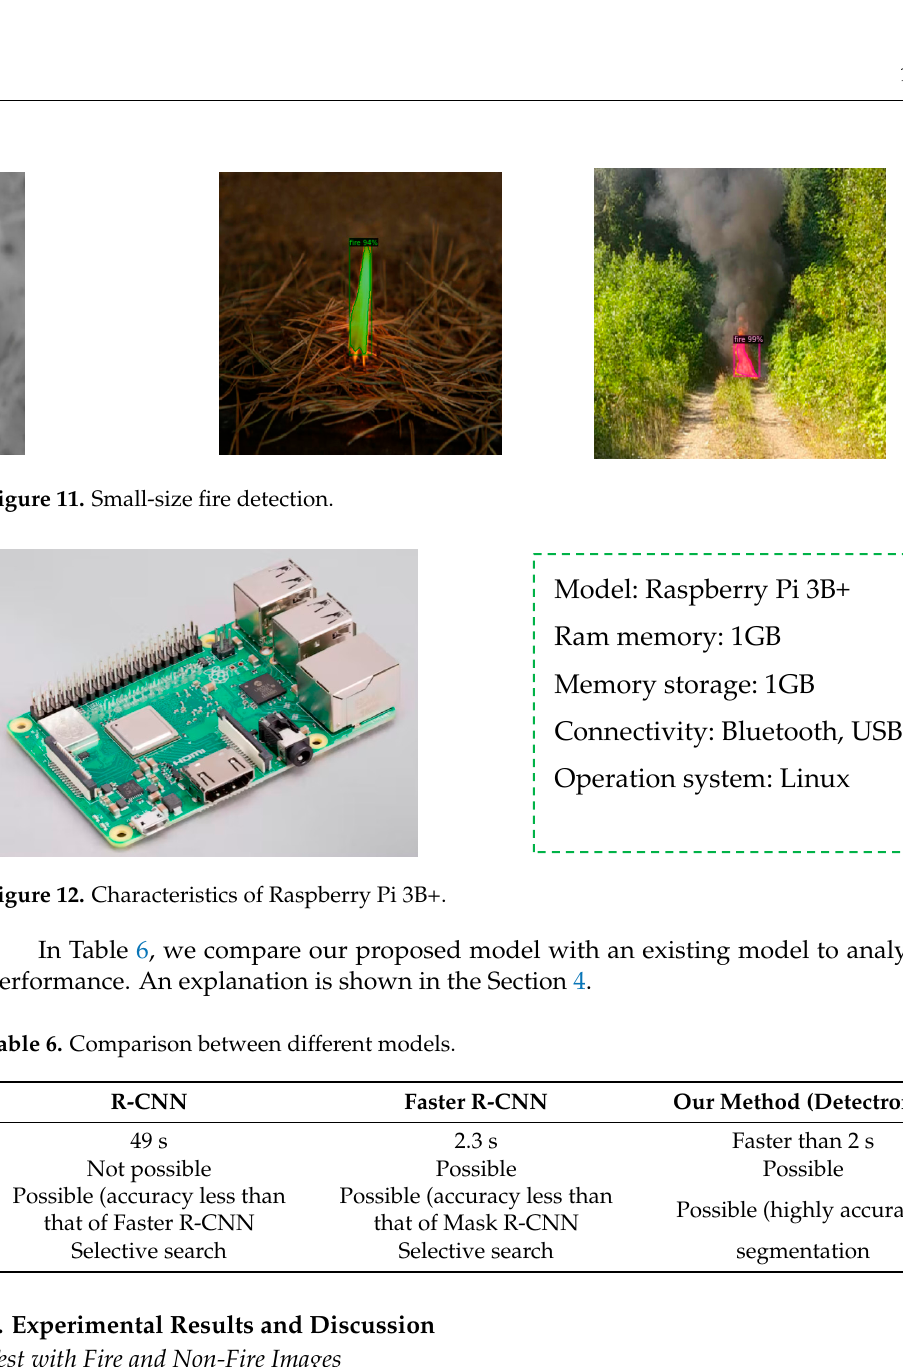
Figure 13. Results of forest fire detection for day images.